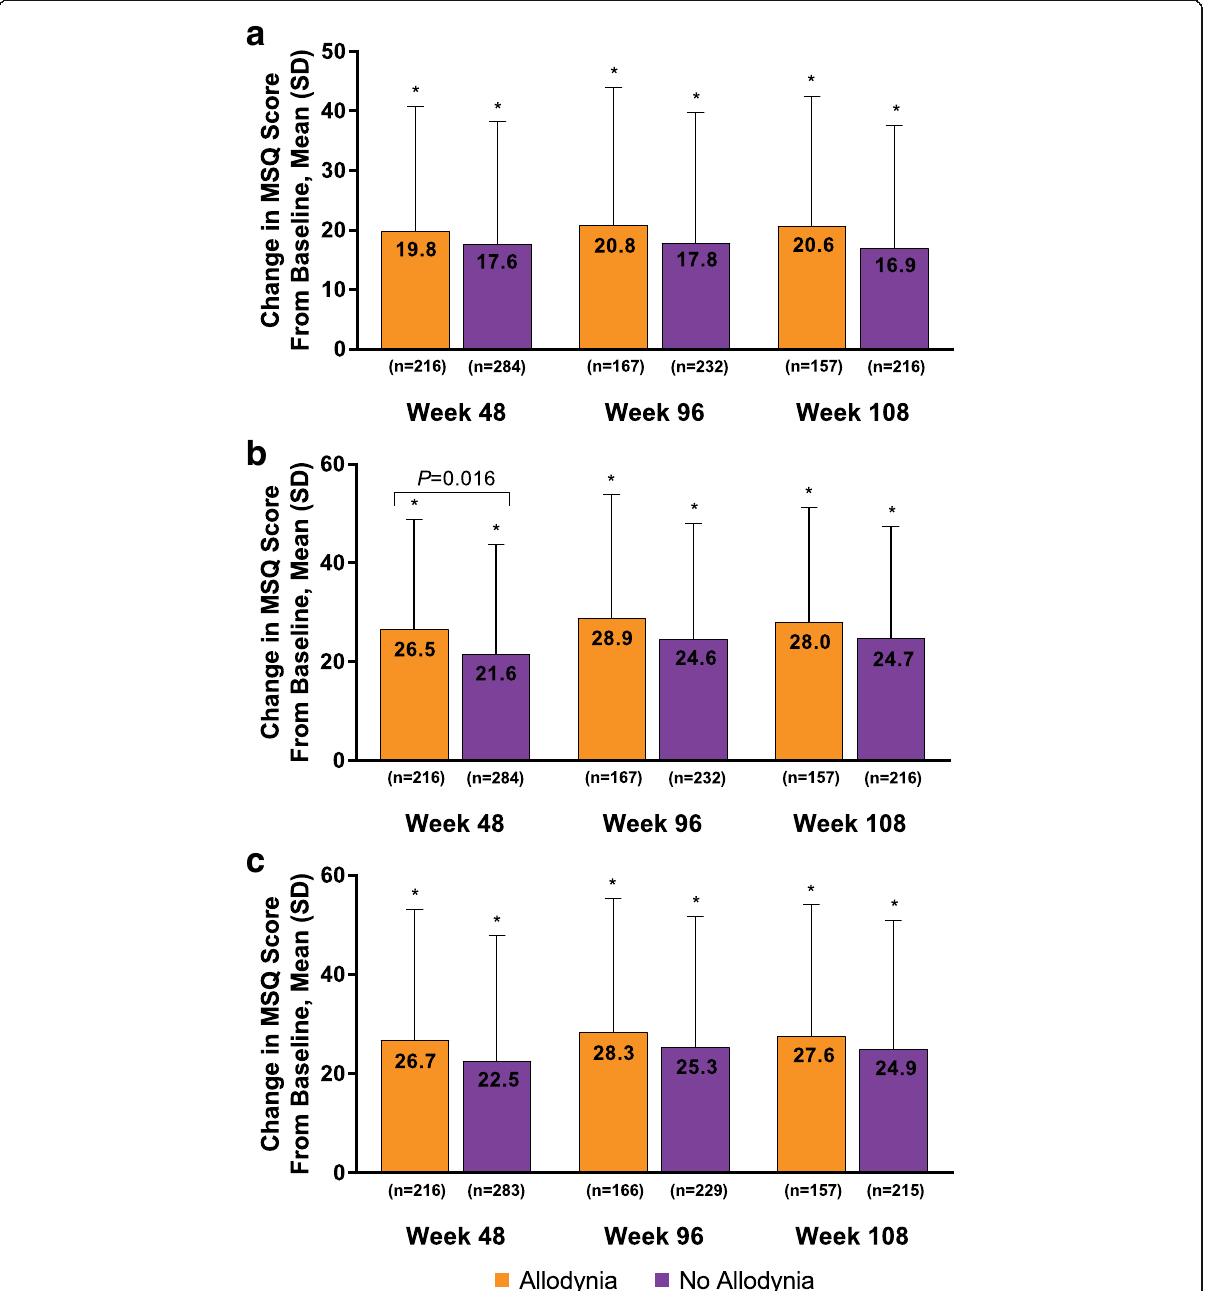
Fig. 3 OnabotulinumtoxinA effect on MSQ (a) Role Function Preventive, (b) Role Function Restrictive, and (c) Emotional Function subscores. MSQ = Migraine-Specific Quality-of-Life Questionnaire. *Indicates P < 0.001 for within-group comparison from baseline. P values shown in the figure indicate between-subgroup differences in change from baseline; data are observed